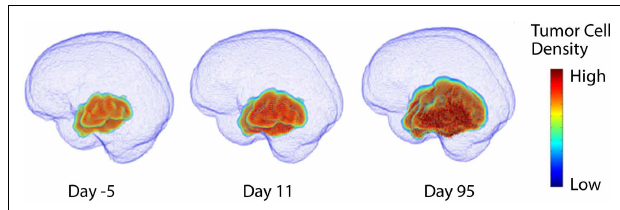
FIGURE 2 |Three dimensional simulation of diffuse tumor invasion and proliferation predicted by the PI model which accounts for differential motility of tumor cells in gray and white matter. Malignant glioma cells can migrate up to 100-fold faster in white matter than in gray, characterizing the extent of invisible subclinical